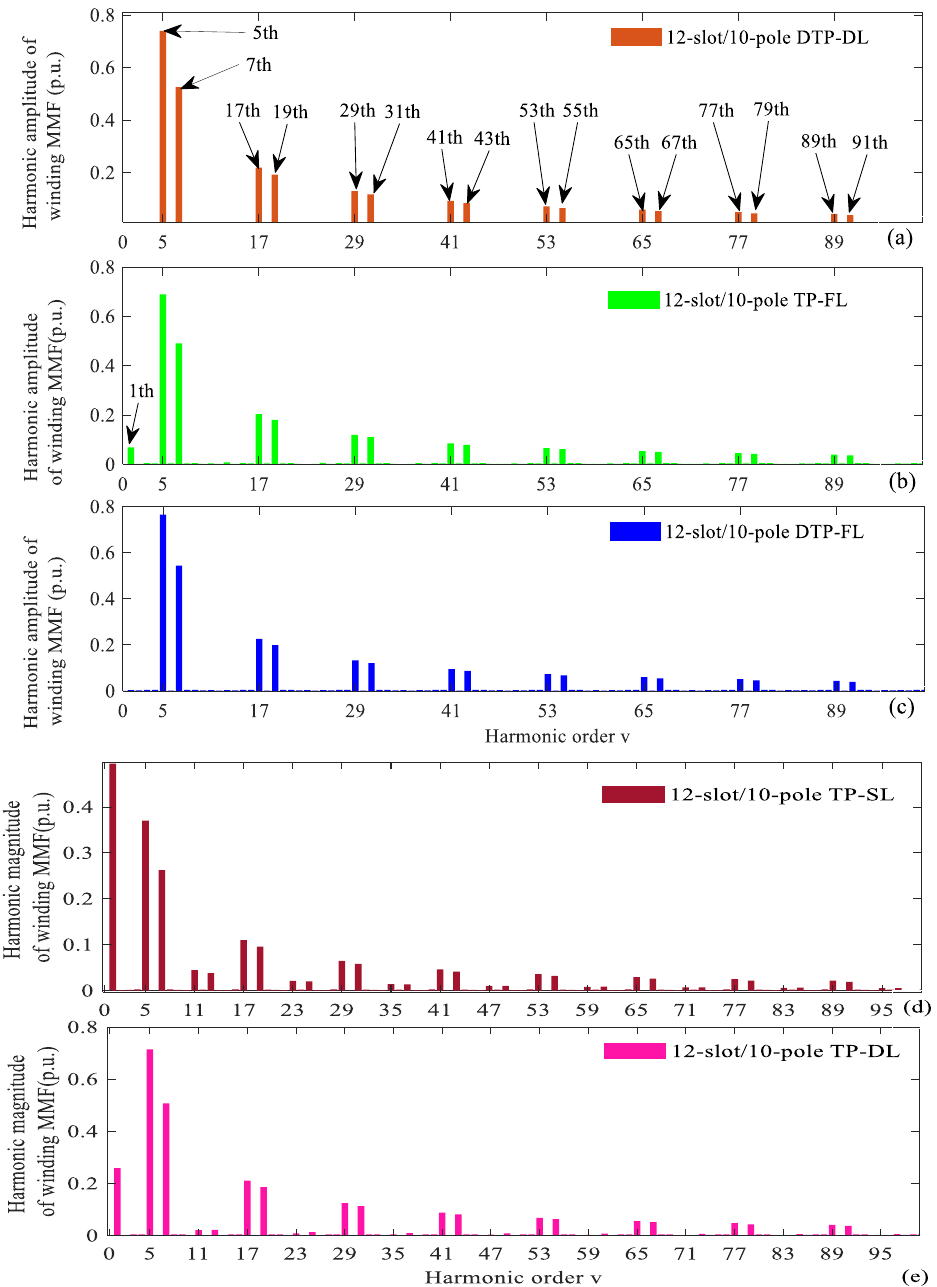
Figure 15. Harmonic decomposition of winding MMF for 12-slot/10-pole. ( a ) DTP-DL, ( b ) TP-FL, ( c ) DTP-FL, ( d )TP-SL, ( e ) TP-DL.